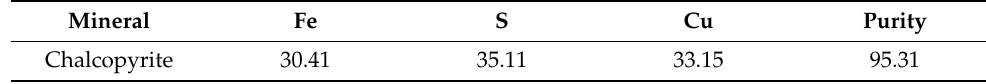
Figure 1. The chalcopyrite electrode used in the electrochemical test was cut and polished from selected chalcopyrite monocrystalline with good crystallinity. The copper sulfide ore used in the closed-circuit test was mined from a mine in Jiangxi province. Table 1. Chemical composition of chalcopyrite (%).